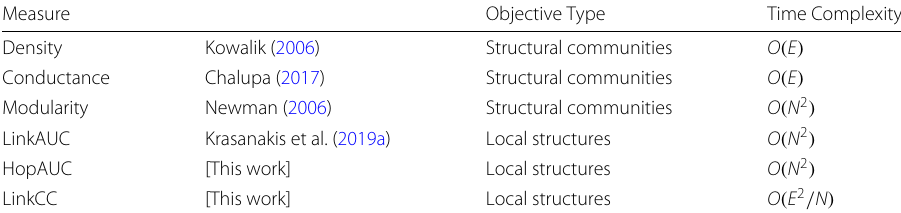
Table 1 Proposed measures to assess node rank quality Measure Objective Type Time Complexity Density Kowalik (2006) Structural communities O ( E ) Conductance Chalupa (2017) Structural communities Modularity Newman